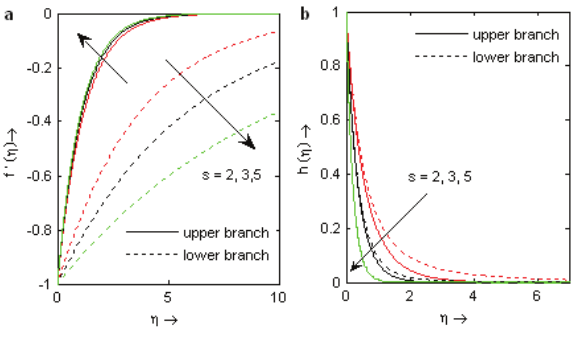
Figure 2. (a) Dual velocity profiles f 0 .(cid:17)/ and (b) Dual tem- perature profiles h ( (cid:17)/ for various values of s with k D (cid:0) 1 ,